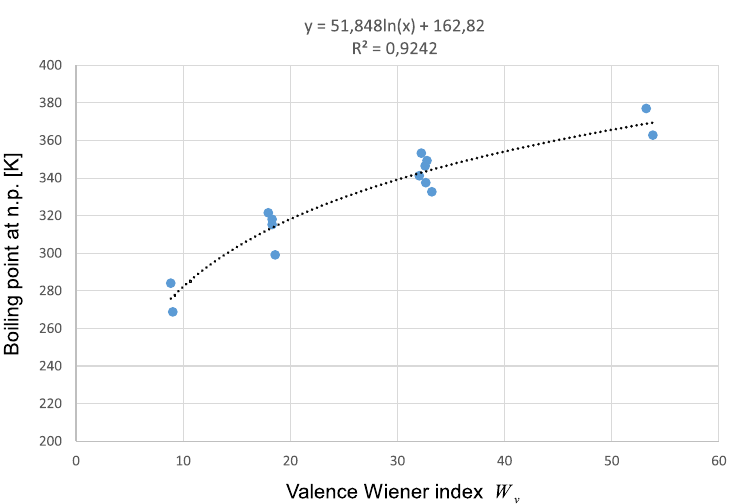
Figure 8. Valence Wiener indices W v and boiling points for the unbranched